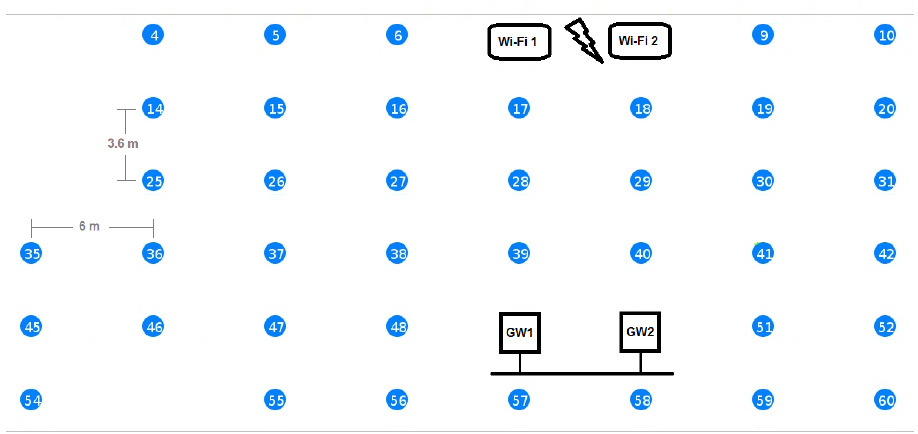
Figure 6. Experimental setup at w-iLab.t Zwijnaarde: generic wireless testbed. The circles represent the location of the